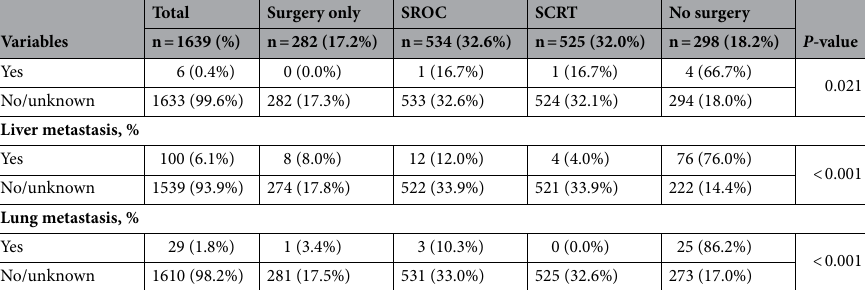
Table 1. The demographics and characteristics of patients according to treatment received. Others a : American Indian/AK Native, Asian/Pacific Islander, unknown; Others b : Divorced, Separated, Widowed, unknown; SRCC: signet ring cell carcinoma; Others c : cystic, mucinous and serous neoplasms; SROC: surgery plus radiotherapy or chemotherapy; SCRT: surgery plus chemoradiotherapy; C16.0/C16.1: Cardia, NOS/Fundus of stomach; C16.2: Body of stomach; C16.3/C16.4: Gastric antrum/ Pylorus; C16.5/C16.6: Lesser curvature of stomach NOS/Greater curvature of stomach NOS; C16.8/C16.9: Overlapping lesion of stomach/ Stomach,